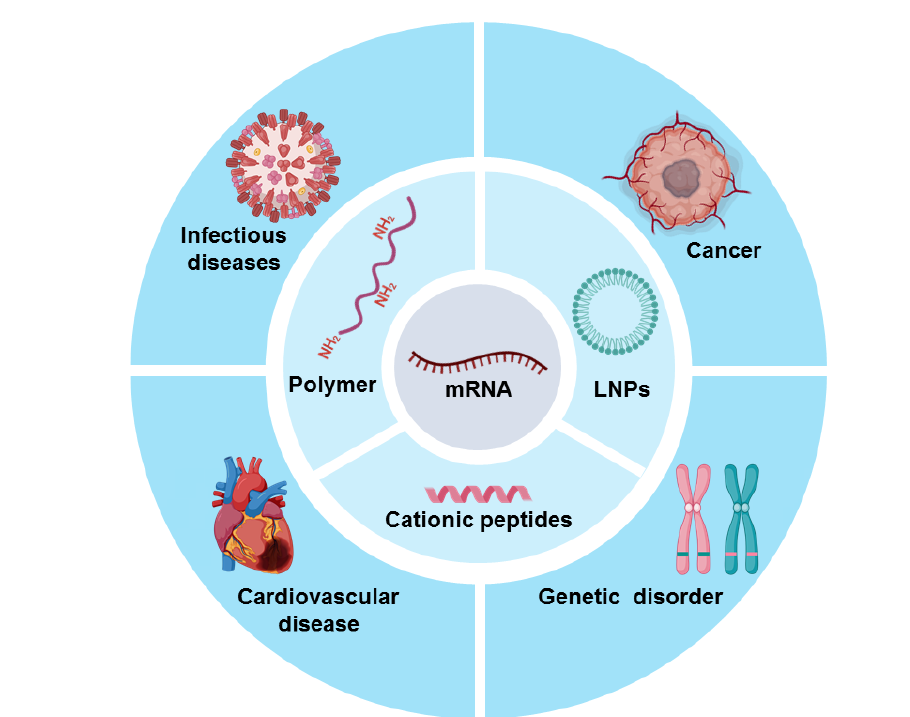
Figure 1. mRNA carriers and disease types of mRNA drug action mRNA carriers